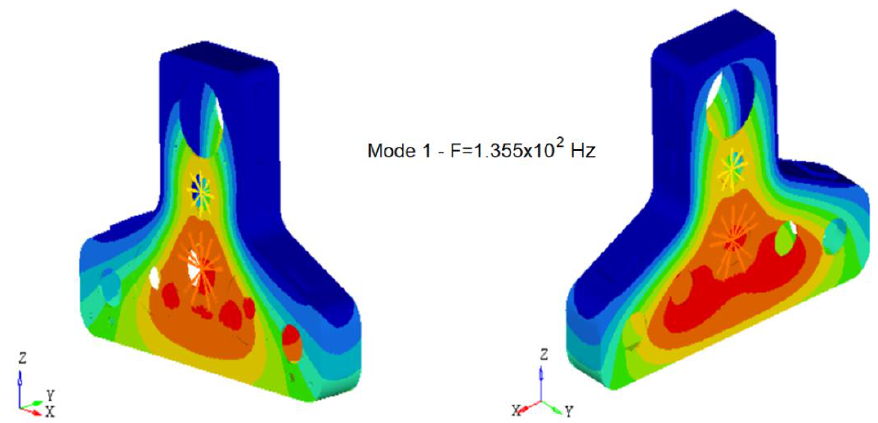
Figure 6. Eigenmode 1 (frequency — 135.51 Hz).